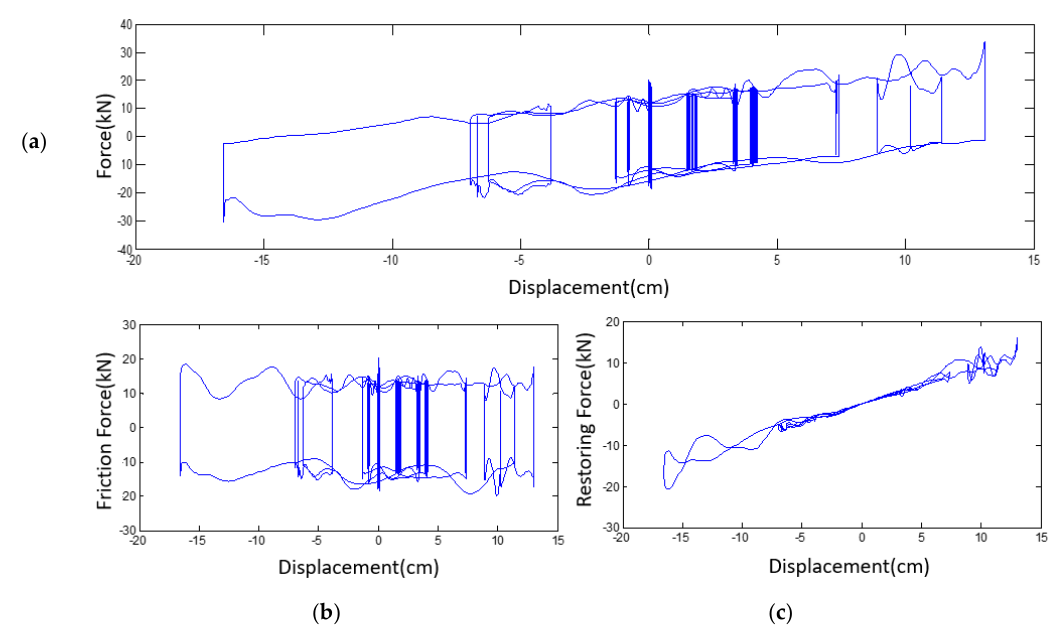
Figure 10. ( a ) Intrinsic force-deformation response of a conventional CSFS. ( b ) Decomposed friction force of a conventional CSFS. ( c ) Decomposed restoring force of a conventional curved surface friction